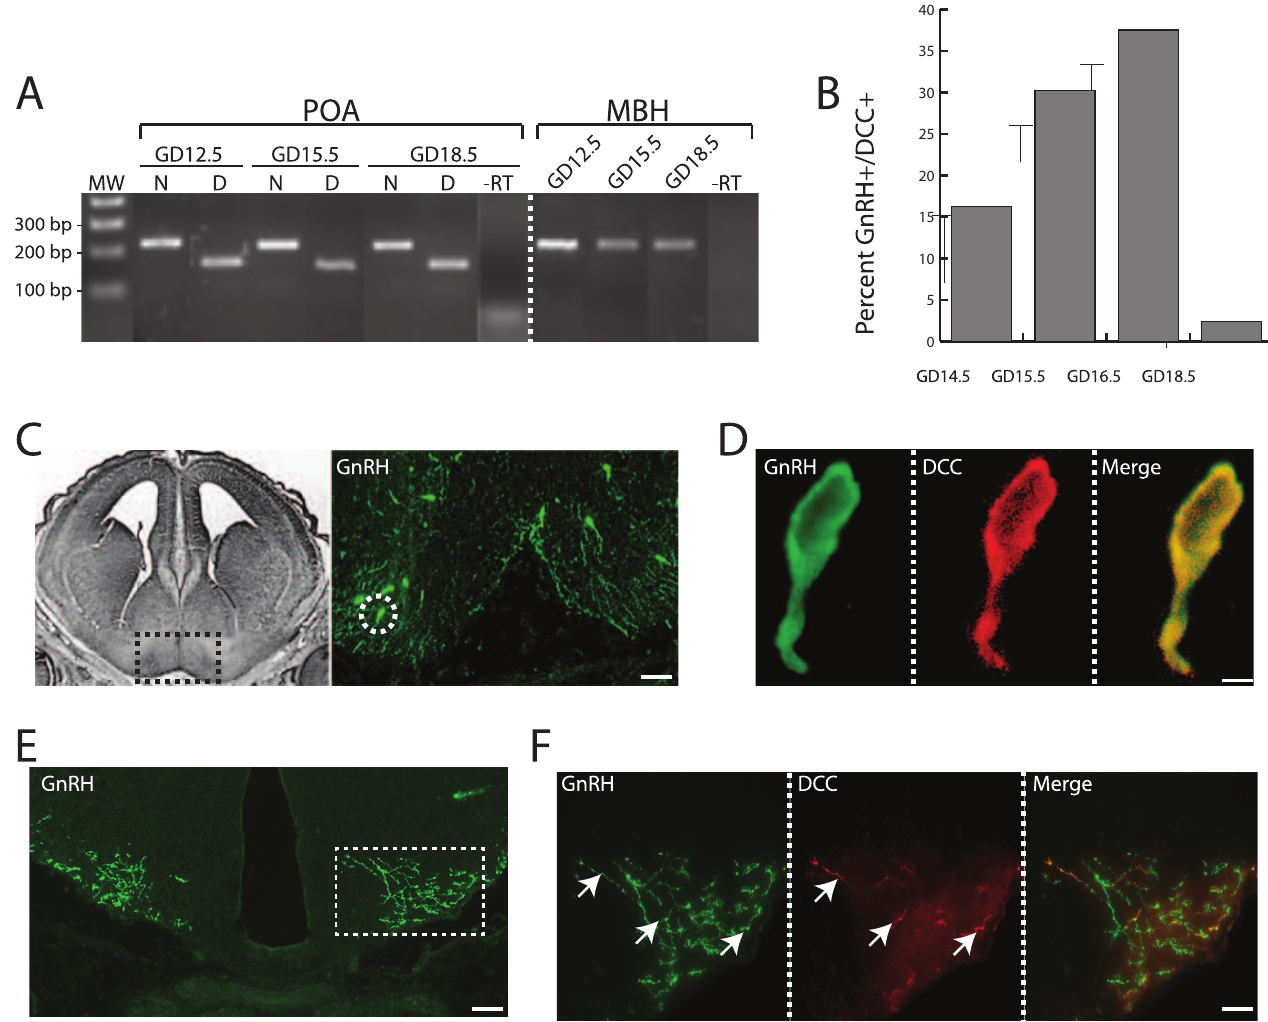
Figure 1. Expression of Netrin-1 and its receptor DCC in developing GnRH neurons and target areas. (A) Composite image showing agarose gel electrophoresis of PCR products. PCR from the preoptic area (POA), across all ages examined (GD 12.5, 15.5, 18.5), showed a band of 219 bp arising from Netrin-1-specific primers (lanes marked with N), and a band of 174 bp arising from DCC-specific primers (lanes marked with D). MW, molecular weight marker. PCR from the mediobasal hypothalamus (MBH) was performed with primers for Netrin-1 only, and again a band of 219 bp is clearly visible. –RT, negative control lanes showing that there are no PCR products from reactions in which the reverse transcription reaction contained no reverse transcriptase, and verifying the specificity of the reactions and the absence of spurious products. (B) Bar graph showing the mean percentage of GnRH-immunoreactive neurons that were also immunoreactive for DCC across the three gestational ages when GnRH neurites are growing to the median eminence. Error bars indicate SEM. (C) Left, black and white image modified from The Chemoarchitectonic Atlas of the Developing Mouse Brain [52] section of GD 16 mouse brain, and depicting the anatomical level from which the immunostained section (right) was taken. Black box indicates region that is shown in the accompanying immunofluorescence photo. Right, representative image of GD 16.5 coronal brain section showing immunostained GnRH (green) neurons (arrows). Dotted white circle indicates one GnRH neuron that is shown dual-labeled with DCC and at higher magnification in (D). Scale bar, 100 m m. (D) High magnification of a single GnRH neuron showing dual-labeling for GnRH peptide (green), DCC (red), two channels merged (yellow). Scale bar, 10 m m. (E) Representative image of GD 16.5 coronal brain section at the level of the ME, and showing immunostained GnRH nerve fibers (green). Dotted box demarcates stained fibers, and indicates the area that is shown in higher magnification in (F). Scale bar, 100 m m. (F) High magnification of GnRH nerve fibers at the ME showing dual-labeling for GnRH peptide (green), DCC (red), and the two channels merged. Arrows indicate GnRH fibers that are co-expressing DCC protein. Scale bar, 10 m